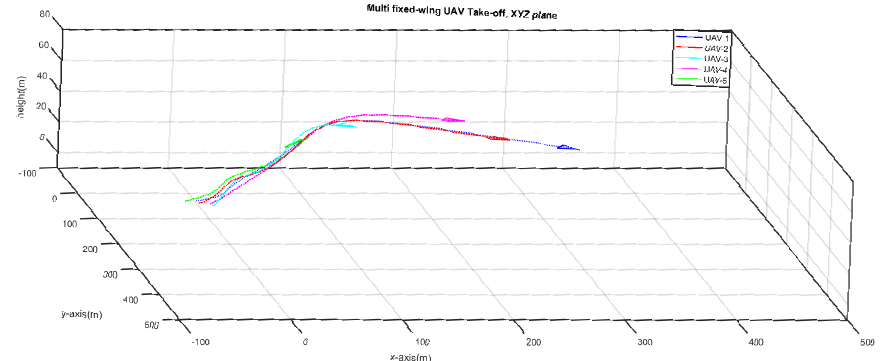
Figure 15. UAVS taking-off from different positions at different time